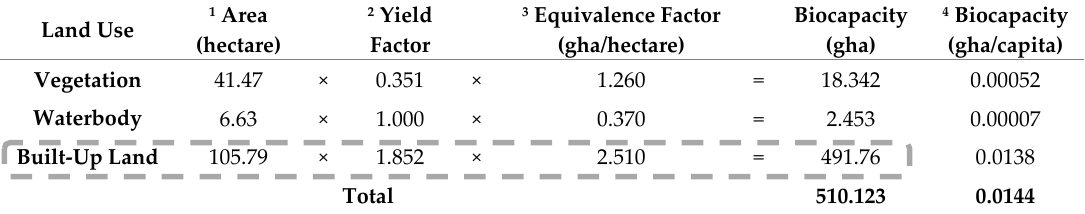
Table 6. Biocapacity calculation (Ward 24).